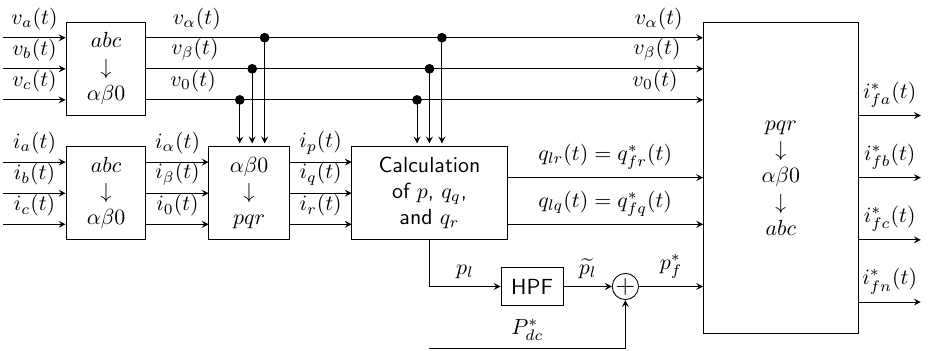
Figure 4 for a block diagram of Rotating PQR Theory.